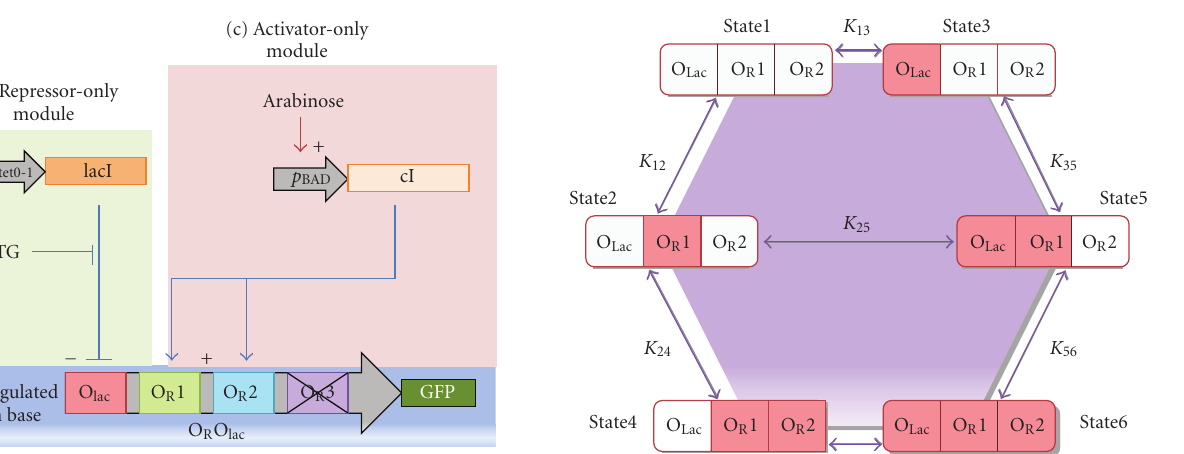
Figure 7: Design concept for the repressor-activator system in Guido et al. [8]. The repressor-activator system was assembled by combining (a) an unregulated system base with (b) a repressor- only module and (c) an activator-only module. The unregulated system consists of an O R O lac promoter driving GFP expression. The rectangular boxes in the promoter are the binding sites for the lacI and cI proteins. The cross at O R 3 indicates a point mutation that inhibits cI binding at this site. In (b), the repressor-only module, the promoter p Ltet0-1 controls the transcription of lacI, which binds to the O lac site to repress the O R O lac promoter. The extent of this e ff ect can be tuned by using the lacI inhibitor IPTG, which reduces the binding of lacI protein to the O lac site. In (c), the activator- only module, the p BAD promoter controls the transcription of cI, which can bind to either the O R 1 or the O R 2 sites, sequentially or cooperatively, to activate the O R O lac promoter. The extent of this e ff ect can be tuned through arabinose, which activates the p BAD promoter (adapted from Guido et al. [8]).